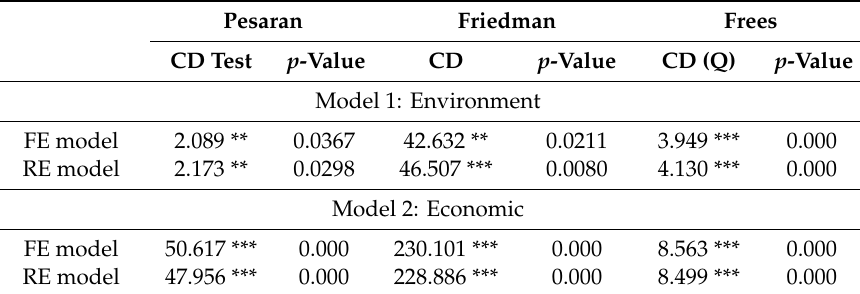
Table 3. Sectional independence